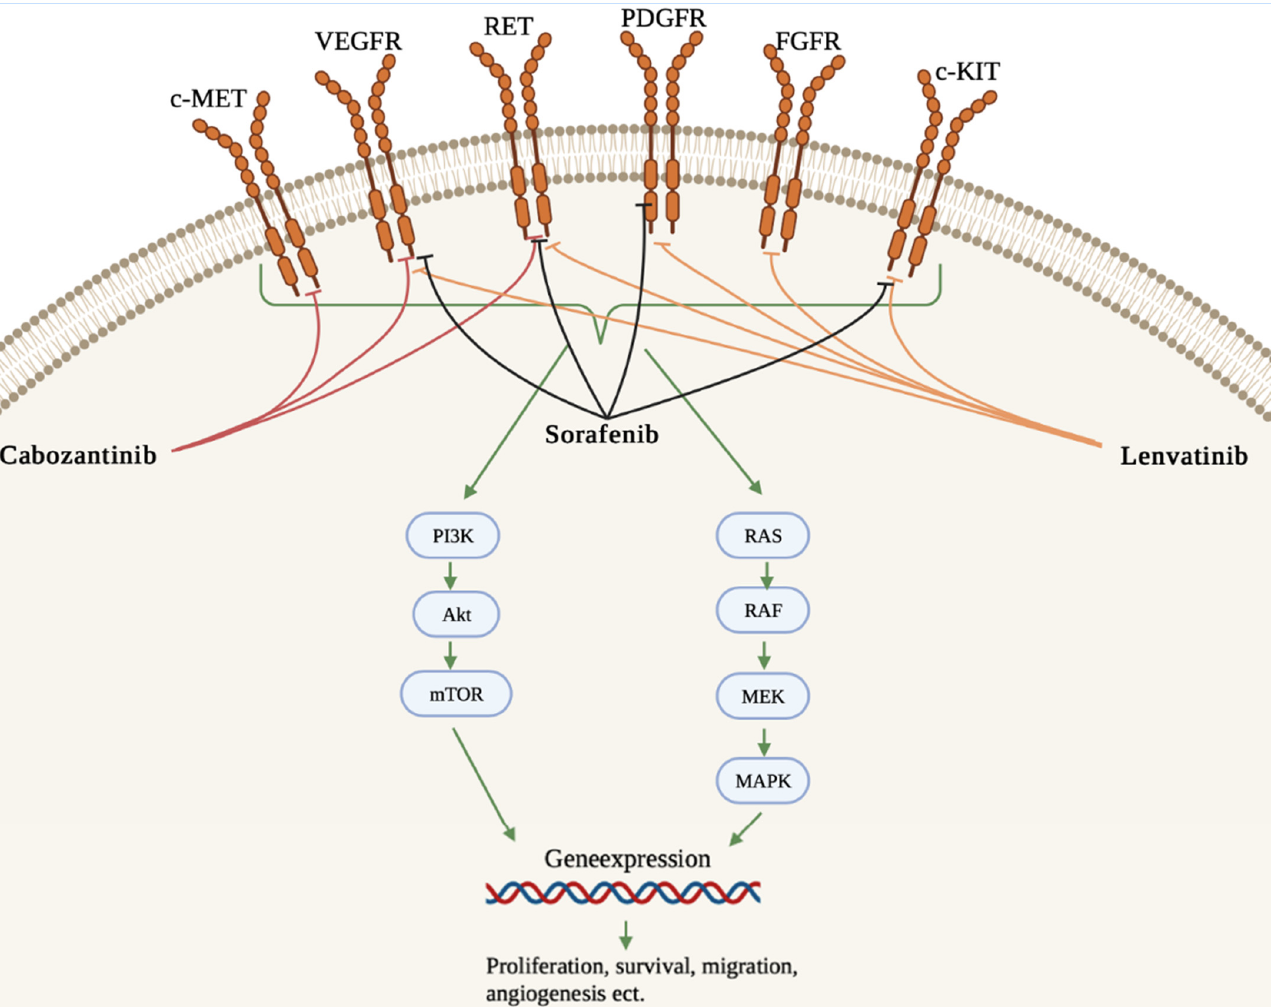
Figure 1. Targets of sorafenib, lenvatinib and cabozantinib. The intracellular signaling pathway MAPK and the PI3K/AKT/mTOR pathway are involved in the development of TC. VEGFR (vascular endothelial growth factor receptor), PDGFR (platelet-derived growth factor receptor), FGFR (fibroblast growth factor receptor), RET (rearranged during transfection), c-KIT (stem cell factor receptor), RAS (rat sarcoma protein), MET (Hepatocyte growth factor receptor), RAF (rapidly accelerated fibrosarcoma kinase), MEK (mitogen-activated protein kinase kinase), MAPK (mitogen-activated protein kinase), PI3K (phosphoinositide 3-kinase), AKT (protein kinase B), mTOR (mammalian target of rapamycin) [9,18,45]. Adapted from [9,18,49]. The figure was drawn using Biorender.com (accessed on 21 October 2021).